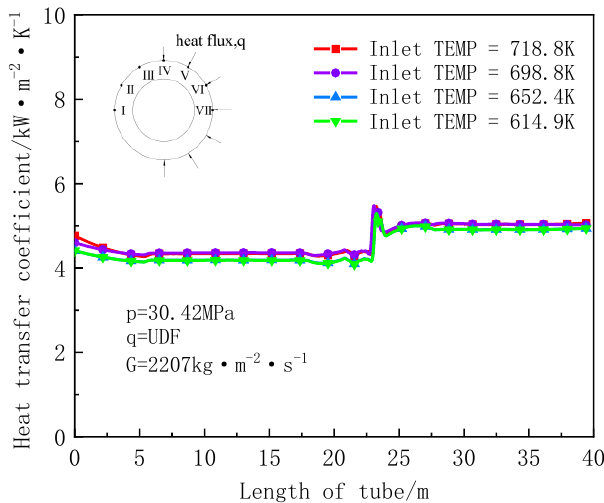
Figure 16. Heat transfer coefficient of the tube length at different inlet temperatures ( p = 30.42 MPa, G = 2207 kg/(m 2 · s), T = 614.9~718.8 K).